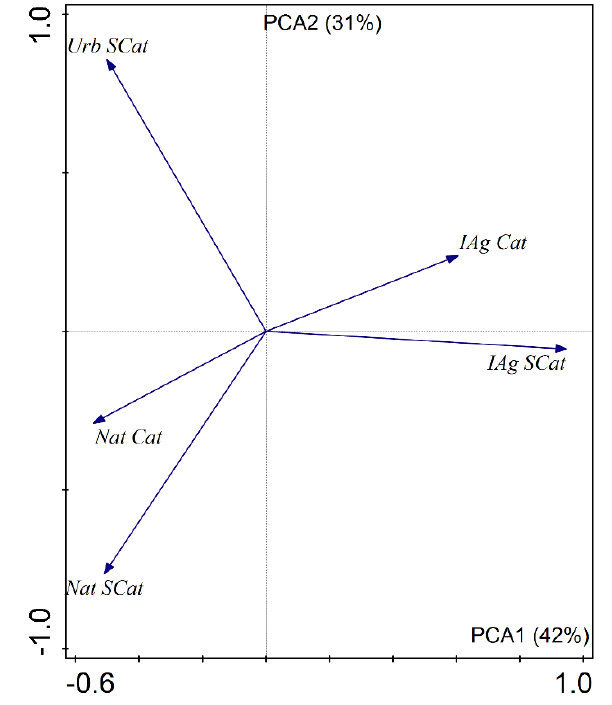
Figure 7. PCA ordination diagram of the first two ordination axes with the land use and nutrient variables ( n = 70). Environmental variables correlated <0.5 with PCA1 or PCA2 were omitted. Urb—urban, Nat—natural, IAg—intensive agriculture, Cat—catchment, and SCat—subcatchment. See Table 1 for the environmental variable codes.